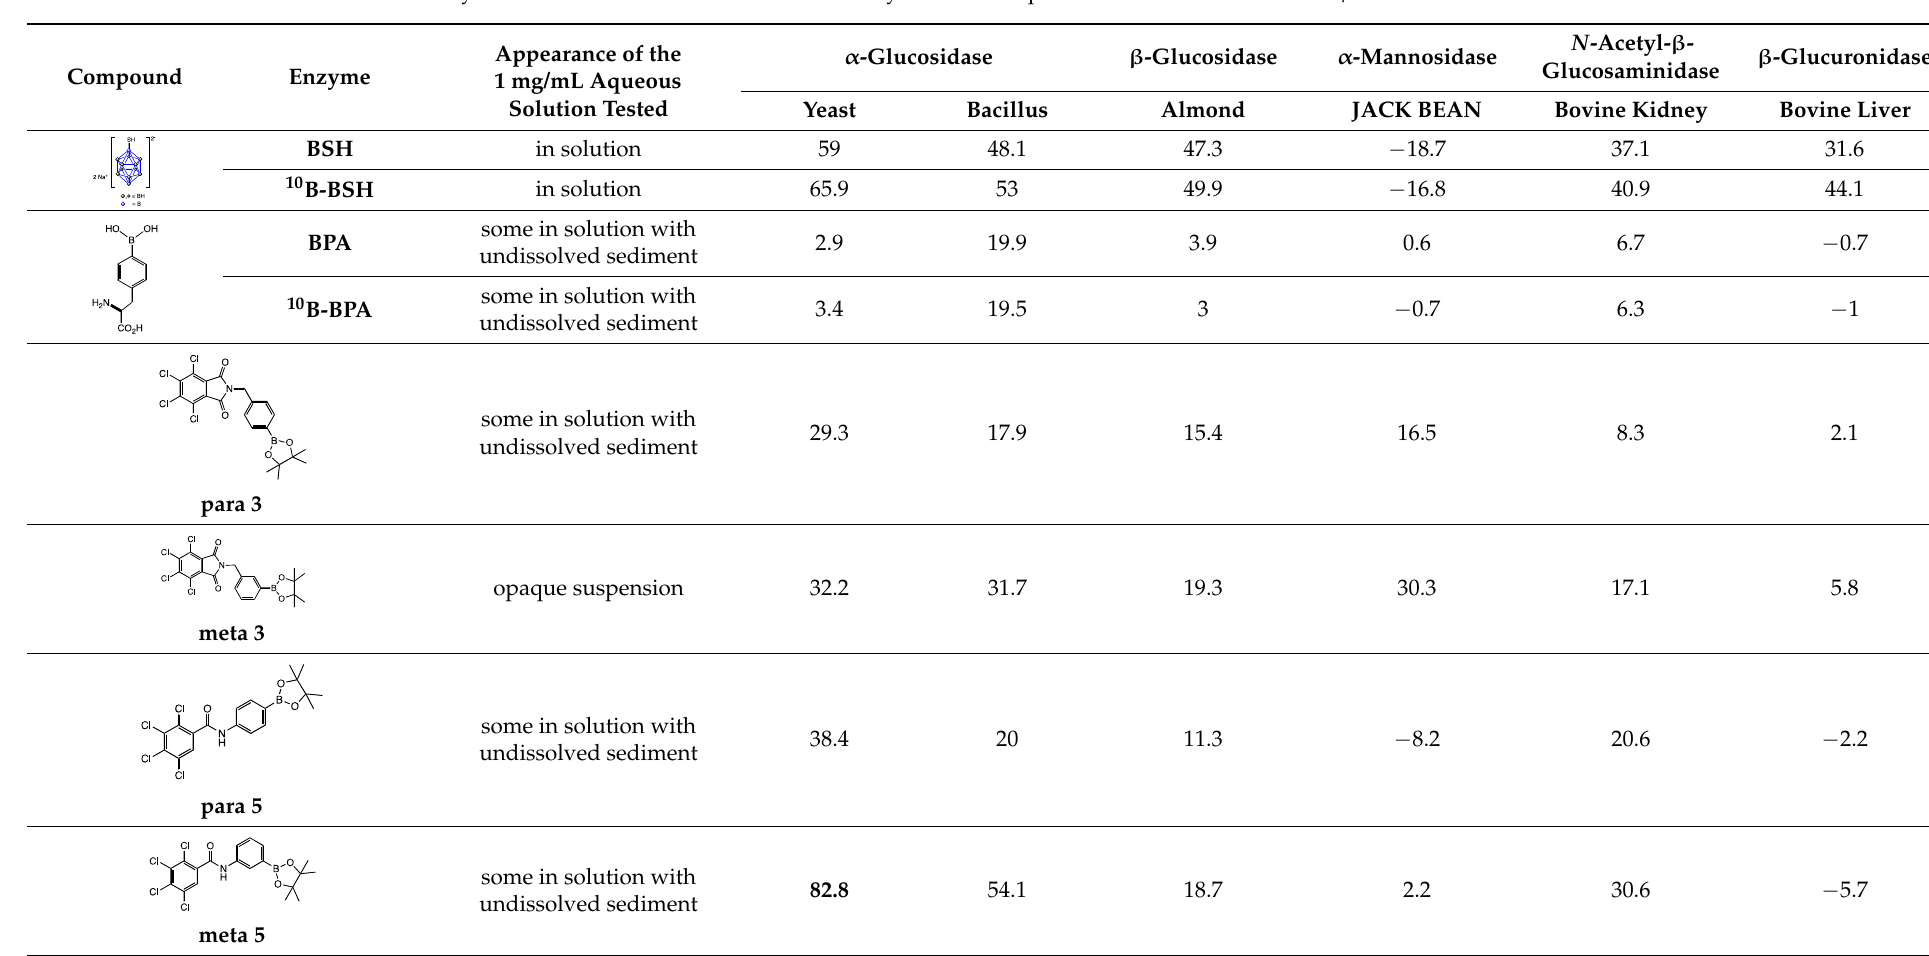
Table 2. Glycosidase inhibition studies from laboratory 2. Results expressed as % inhibition at ~400 µ M. Compound Appearance of the 1 Enzyme mg/mL Aqueous Solution Molecules 2021 , 26 , x FOR PEER REVIEW